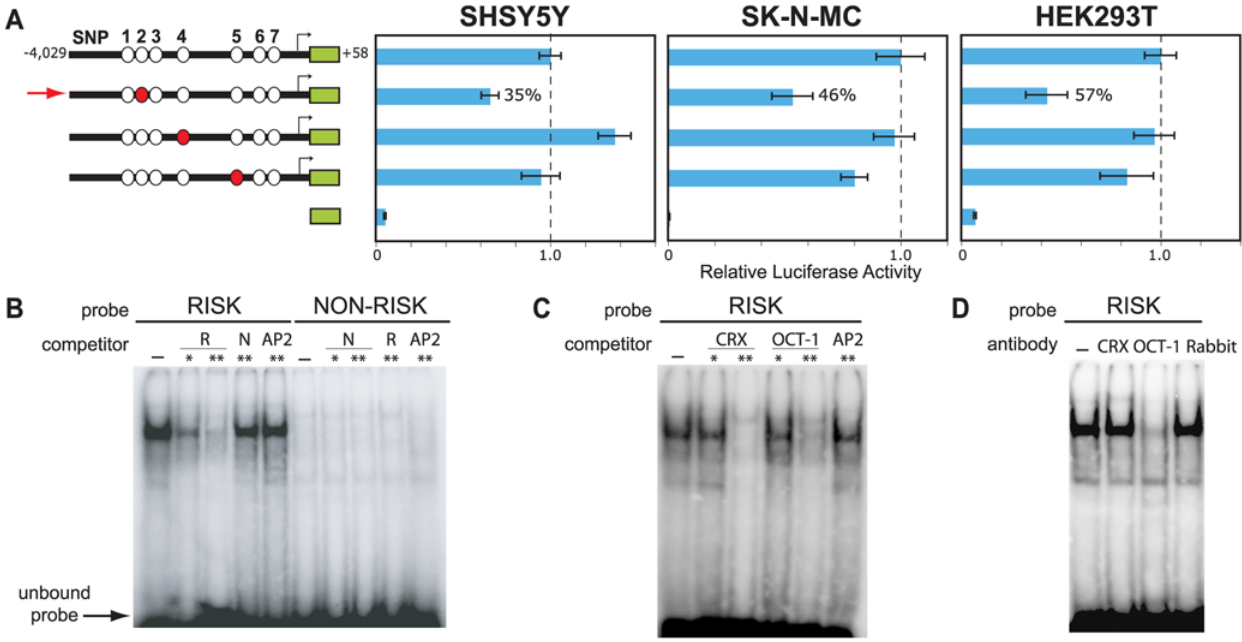
Figure 3. Effect of risk versus non-risk variants on luciferase expression and nuclear protein binding. (A) Luciferase expression from constructs containing the risk versus non-risk variants of SNPs 2, 4, and 5 was measured in SHSY5Y, SK-N-MC, and HEK293T cells. White and red circles represent the non-risk and risk variants, respectively (see Figure 2 for additional features of the depicted constructs). All assays were performed in quadruplicate and repeated at least three times. Error bars represent the standard error of the mean. The vertical dashed line represents the RLA measured for the construct containing the non-risk haplotype (set at 1.0 RLA); note that this reflects a different scale than the RLA depicted in Figure 2. For all three cell lines, only the construct containing the SNP 2 risk variant (denoted with a red arrow) yielded a significant RLA difference compared to the construct containing the non-risk haplotype, as analyzed using an unpaired two-sided t-test (P=8.32 6 10 2 10 , SHSY5Y; P=3.92 6 10 2 7 , SK-N-MC; P=4.02 6 10 2 8 , HEK293T). (B) EMSA testing the binding of SHSY5Y nuclear protein(s) to probes containing the SNP 2 risk versus non-risk variant. The presence of a competitor is denoted above each lane: -, no competitor; R, risk competitor; N, non-risk competitor; AP2, competitor containing an AP2-binding site (negative control); and *, 10-fold and **, 100-fold excess of competitor, respectively. (C) EMSA testing the binding of SHSY5Y nuclear protein(s) to probes containing the SNP 2 risk variant in the presence of competitors containing binding sites for CRX, OCT-1, and AP2 (negative control). (D) Supershift EMSA testing the binding of SHSY5Y nuclear protein(s) to probes containing the SNP 2 risk variant in the presence of anti-CRX or -OCT-1 antibody or general rabbit antiserum.